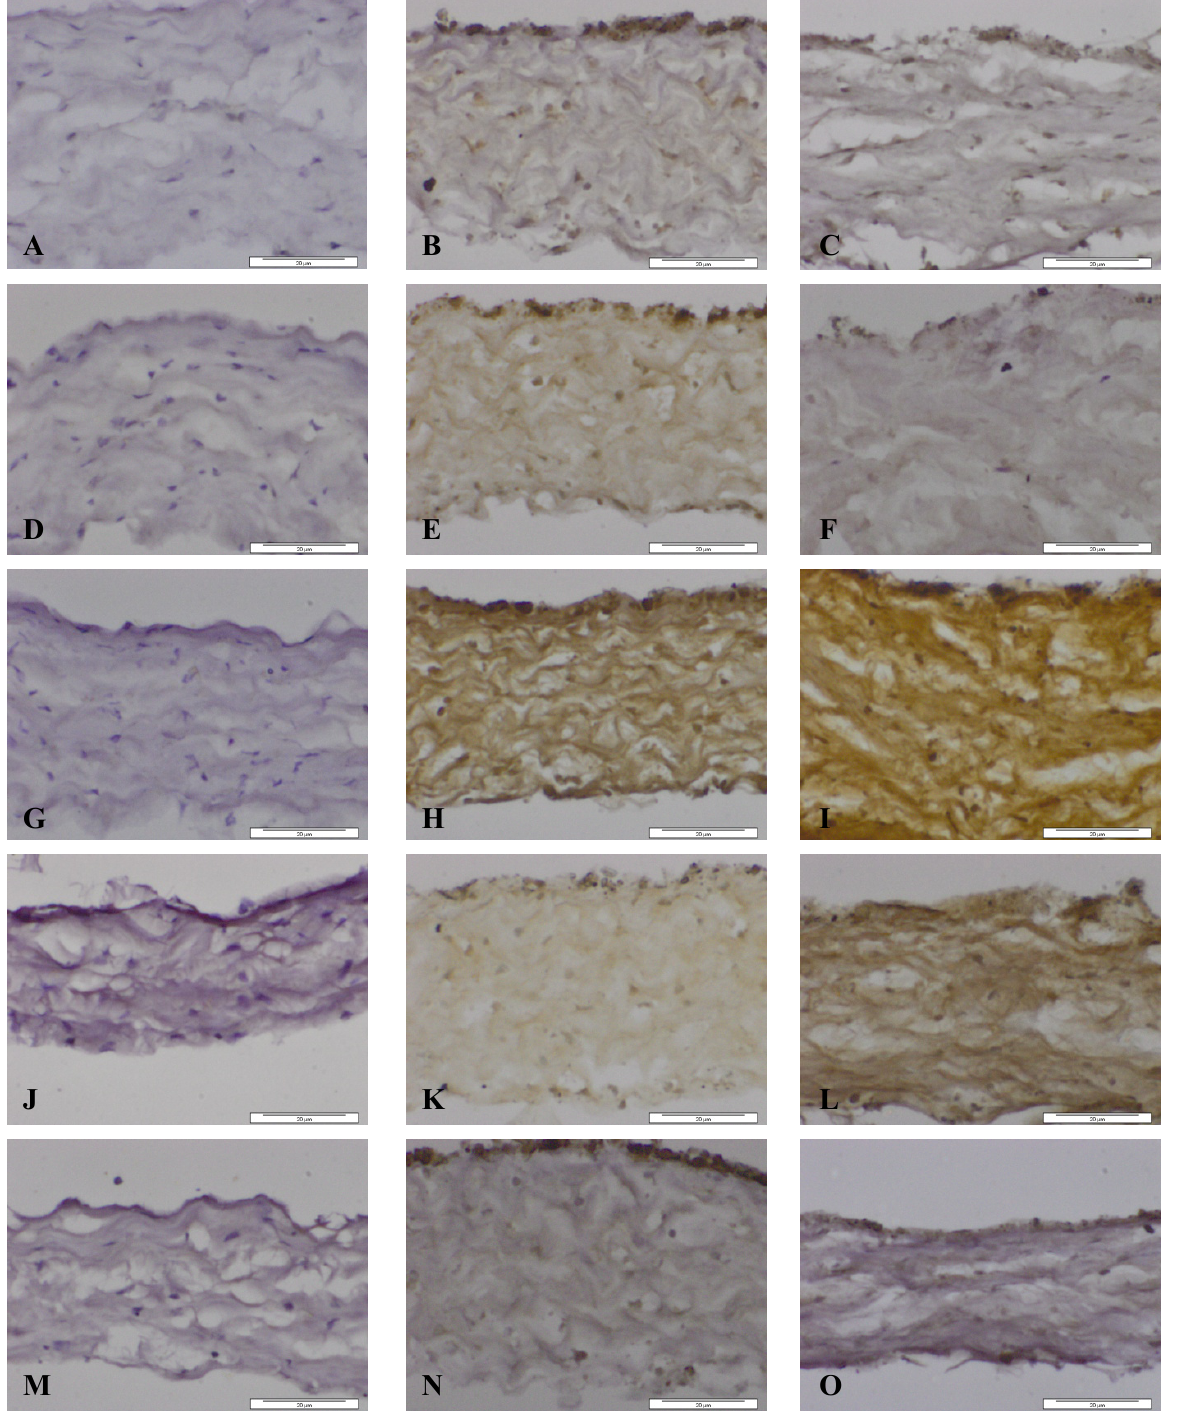
Figure 5. Images of dura mater exposed for seven days to CoCr nanoparticles and stained for the presence of matrix metalloproteinases and TIMP-1 by immunhistochemistry. Images of section of control dura mater tissue ( A , D , G , J , M ), dura mater exposed to an estimated dose of 5 µm 3 CoCr nanoparticles per epithelial cell ( B , E , H , K , N ) and dura mater exposed to an estimated dose of 50 µm 3 CoCr nanoparticles per epithelial cell ( C , F , I , L , O ). The tissues were stained for MMP-1 ( A – C ), MMP-3 ( D – F ), MMP-9 ( G – I ), MMP-13 ( J – L ), TIMP-1 ( M – O